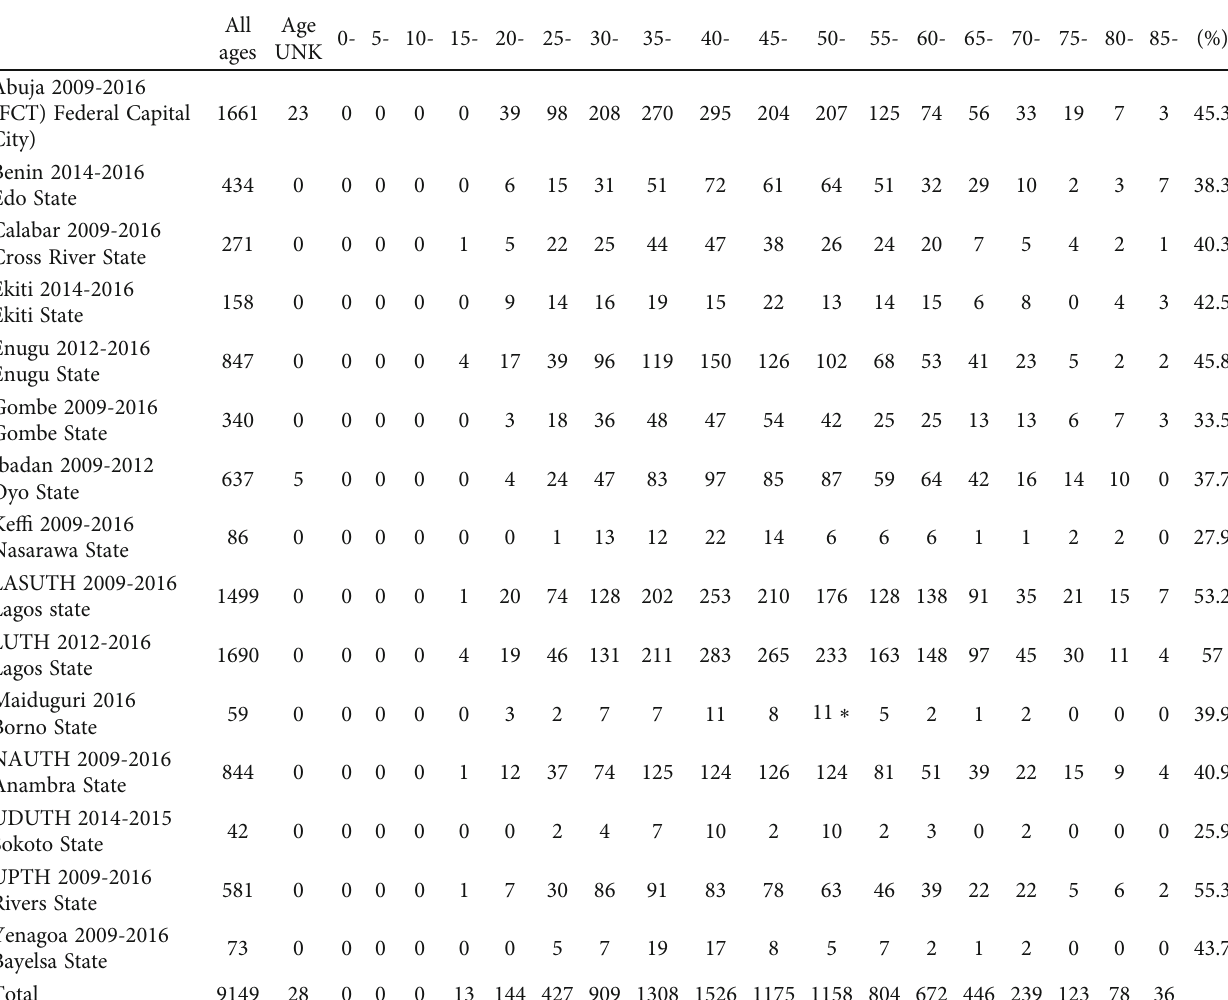
Table 2: Breast cancer in females across all ages in 15 registries in